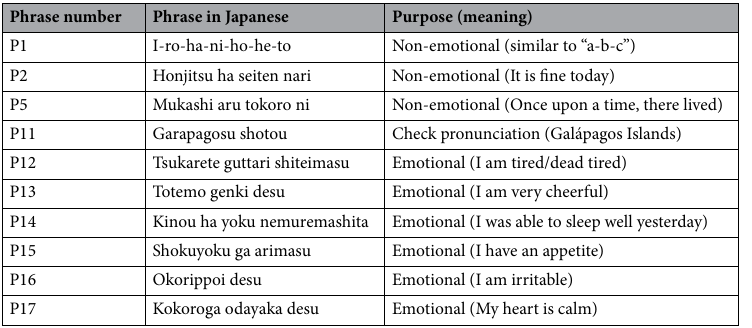
Table 1. Ten phrases used for analysis.